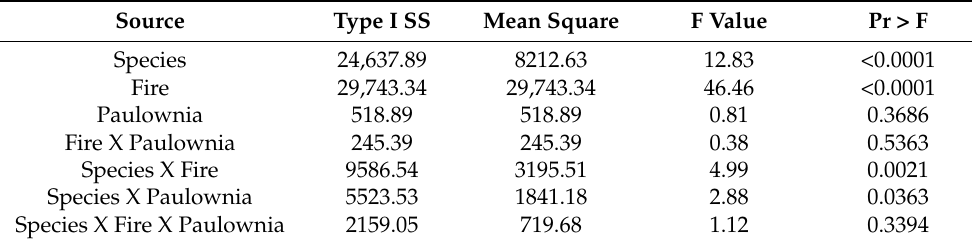
Table 4. Statistics of the three-way ANOVA examining the effects of species, fire (fire/no fire), paulownia (presence/absence), and their interactions performed on all the height (<137cm) data of all native species combined.